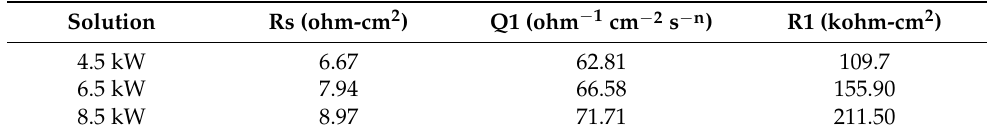
Table 4. EIS fitting data of 2205 DSS in 3.5% NaCl